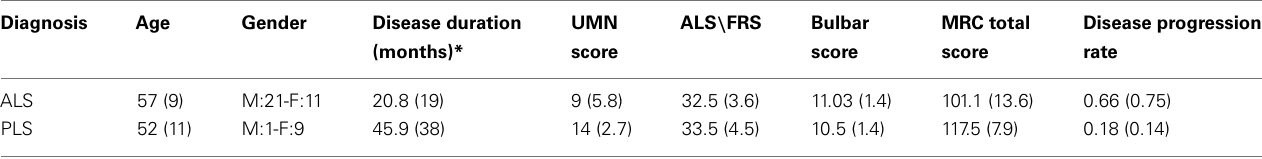
Table 1 | Demographic and clinical characteristics ofALS and PLS patients [mean values (Standard Deviation)] .